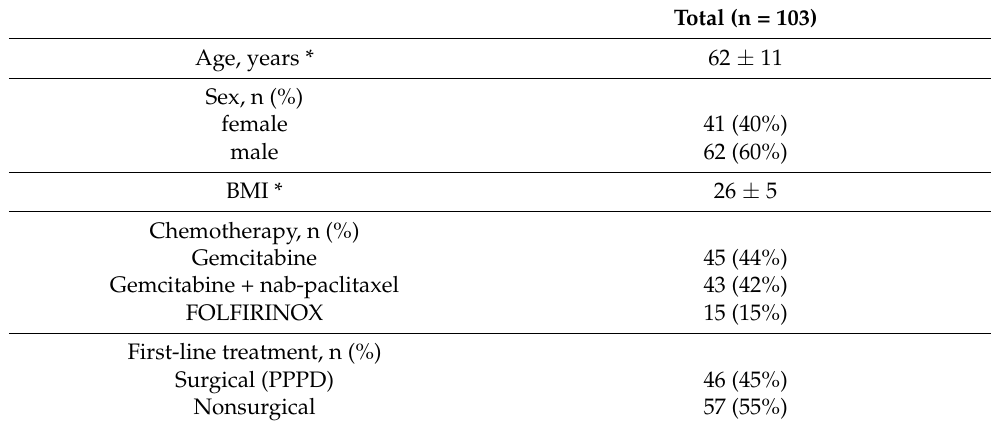
Table 1. Clinical characteristics of all patients with pancreatic adenocarcinoma included in our retrospective analysis. BMI = body mass index. FOLFIRINOX = 5-fluorouracil, folinic acid, irinotecan, and oxaliplatin. PPPD = pylorus preserving pancreatoduodenectomy. * Median ± standard deviation.